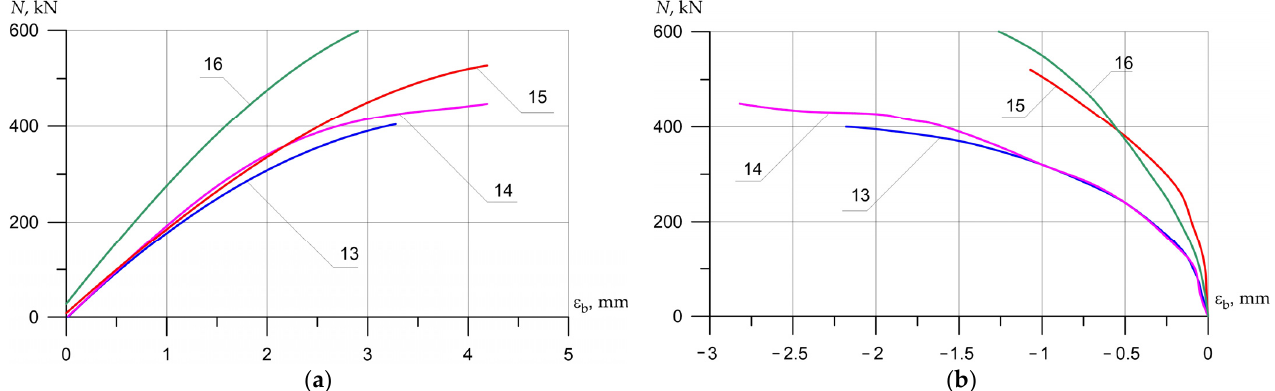
Figure 17. Comparison of the average experimental values of the relative deformations of concrete in compression ( a ) ε b and tension ( b ) ε bt on opposite faces of the columns ( λ h = 10) depending on the load and variants for composite reinforcement with axial eccentricity e 0 = 4.0 cm (0.32 With an eccentricity of